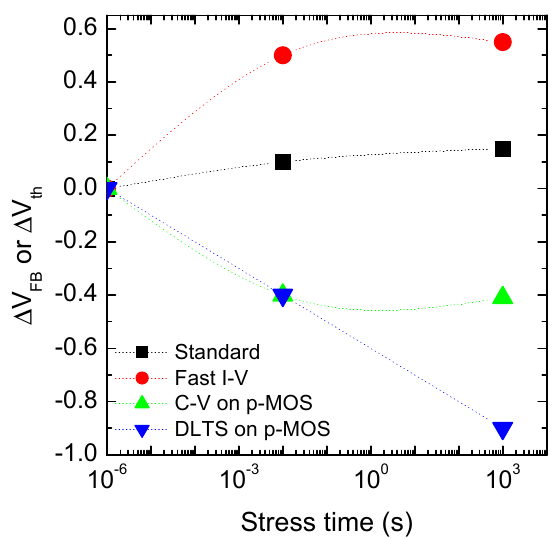
Figure 11. ∆ V FB (equivalent to ∆ V th ) as a function of the stress time measured with di ff erent electrical Figure 11. Δ V FB (equivalent to Δ V th ) as a function of the stress time measured with different electrical characterization techniques. Data taken from Reference characterization techniques. Data taken from Reference [71].